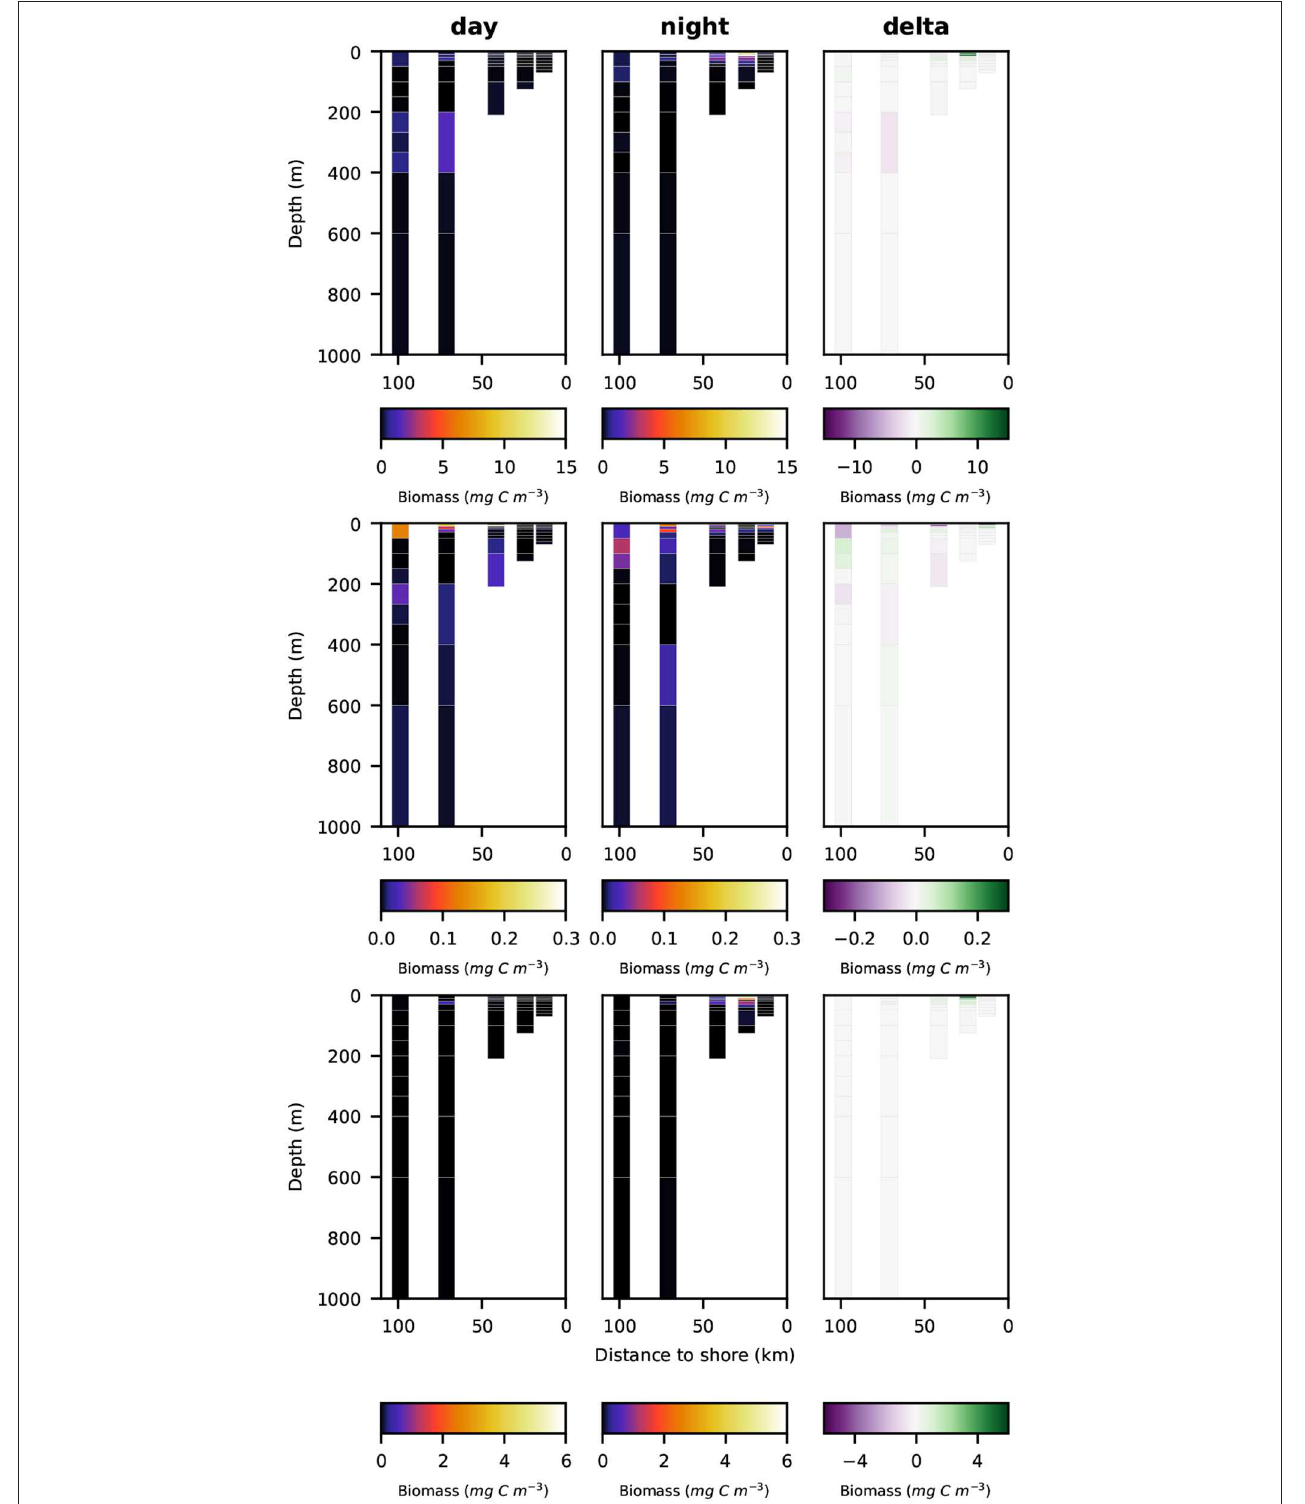
FIGURE 4 | Vertical distribution of zooplankton biomass ( mg C m − 3 ) along the transect at day (left panels), night (middle panels), and the difference of the two (right panels). Top row: total well-preserved zooplankton, middle row: minor-groups, bottom row: Decapoda.